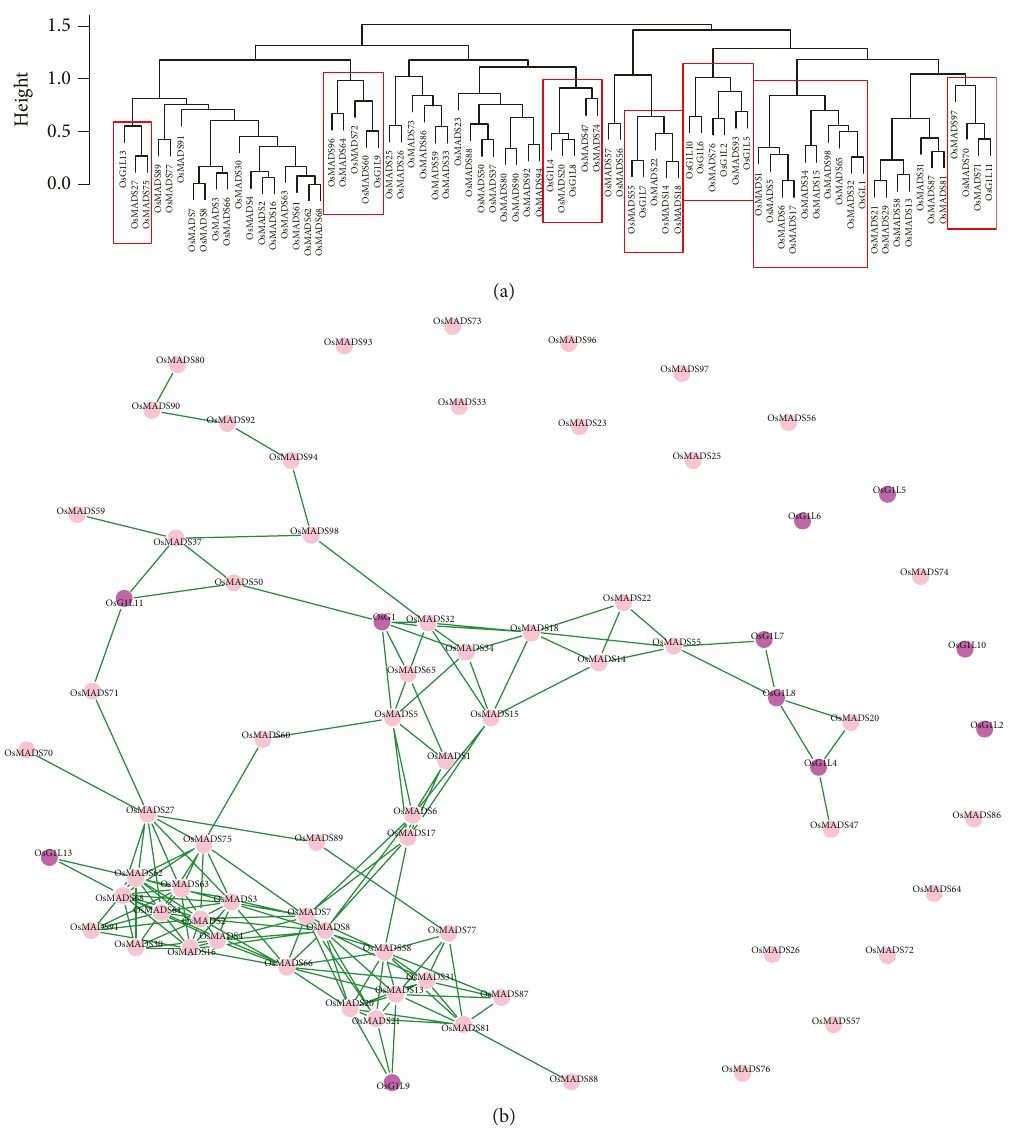
Figure 5: The hierarchical clustering tree and coexpression network between OsG1/G1Ls and MADS-box genes in rice. (a) The hierarchical cluster dendrogram showing coexpression modules. The red boxes represent the analyzed coexpression subgroups. The hierarchical clustering tree of coexpression was constructed with the hclust function in R. (b) The gene coexpression network between OsG1/G1Ls and OsMADS genes. The green lines between two genes represent the coexpression relationships, and their length represents the coexpression signal intensity. The coexpression network was drawn by igraph software with a cut-o ff value of